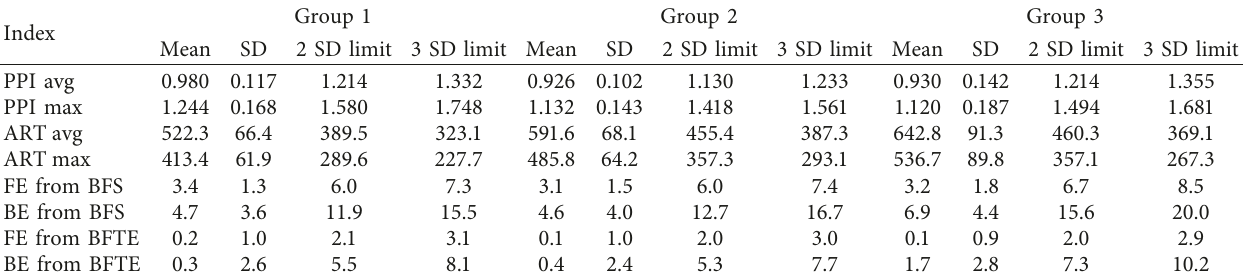
Table 2: The mean, standard deviation (SD), and the suggested cutoff values (2 and 3 SD from the mean) of different parameters in the three groups.